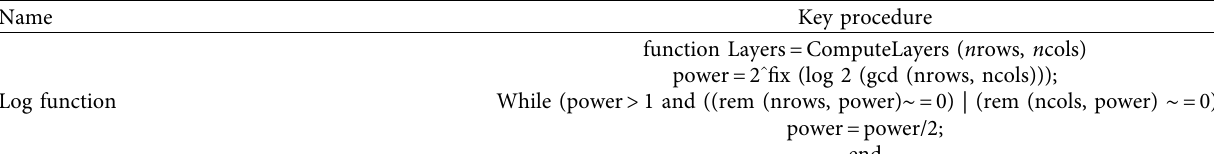
Table 1: The key procedure of the DR image enhancement model. Name Key procedure